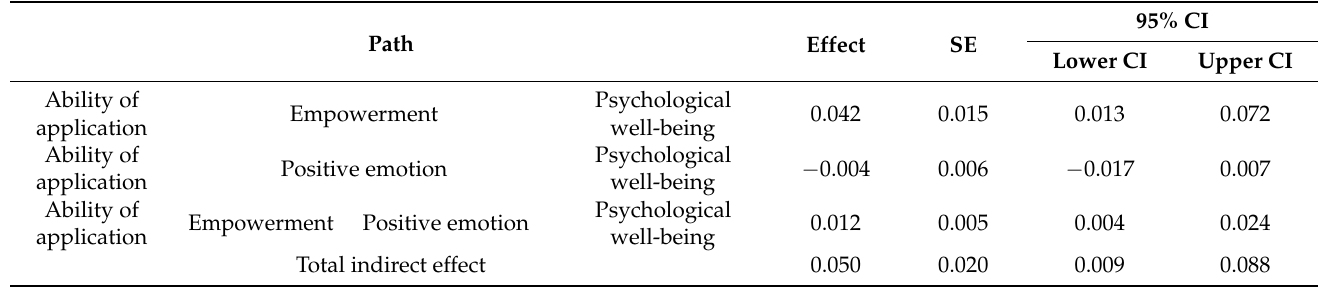
Table 7. Verification of indirect effect of empowerment and positive